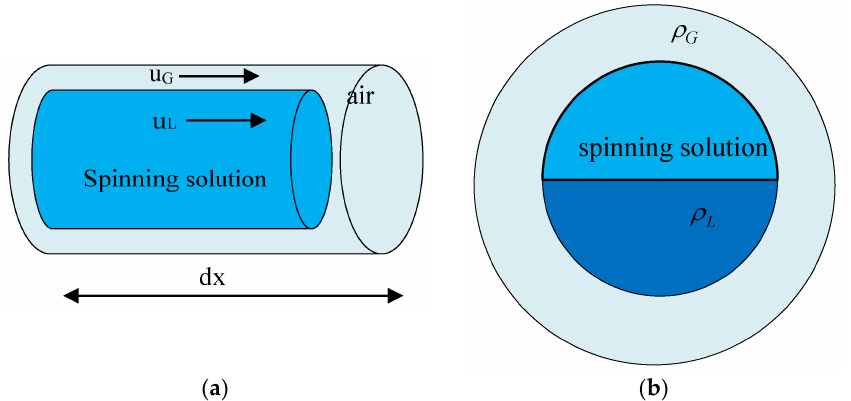
Figure 6. Schematic diagram of polymer gas–liquid slip. ( a ) Schematic diagram of intercepted fiber gas–liquid slip. ( b ) Schematic diagram of gas–liquid interface.